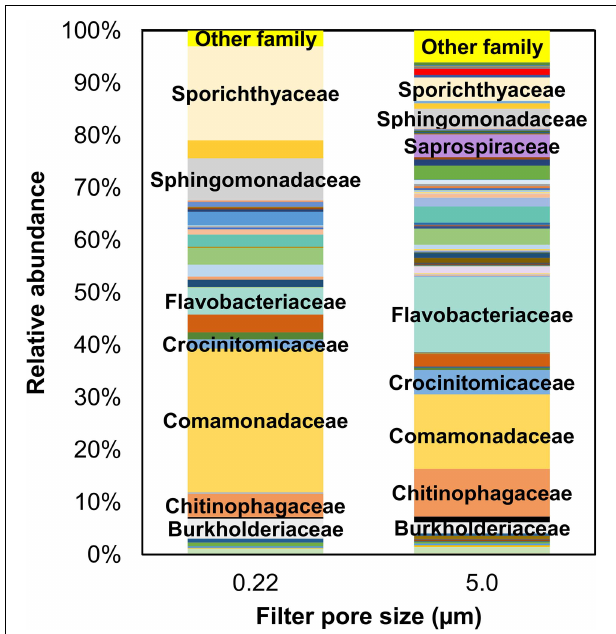
FIGURE 5 | Mean relative abundance of bacterial families identified in water samples from all sampling locations by filter pore size (i.e., 0.22- and 5.0- µ m filters). Only families > 0.1% by relative abundance are included in this illustration; the rest ( < 0.1% by relative abundance) are included under